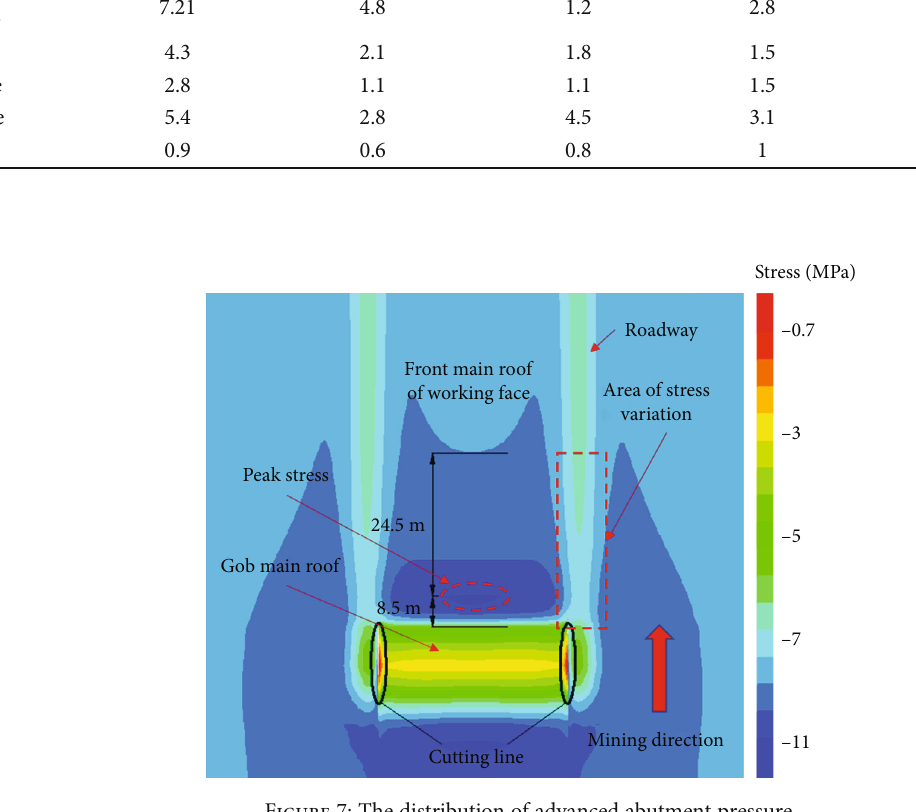
Figure 7: The distribution of advanced abutment pressure.